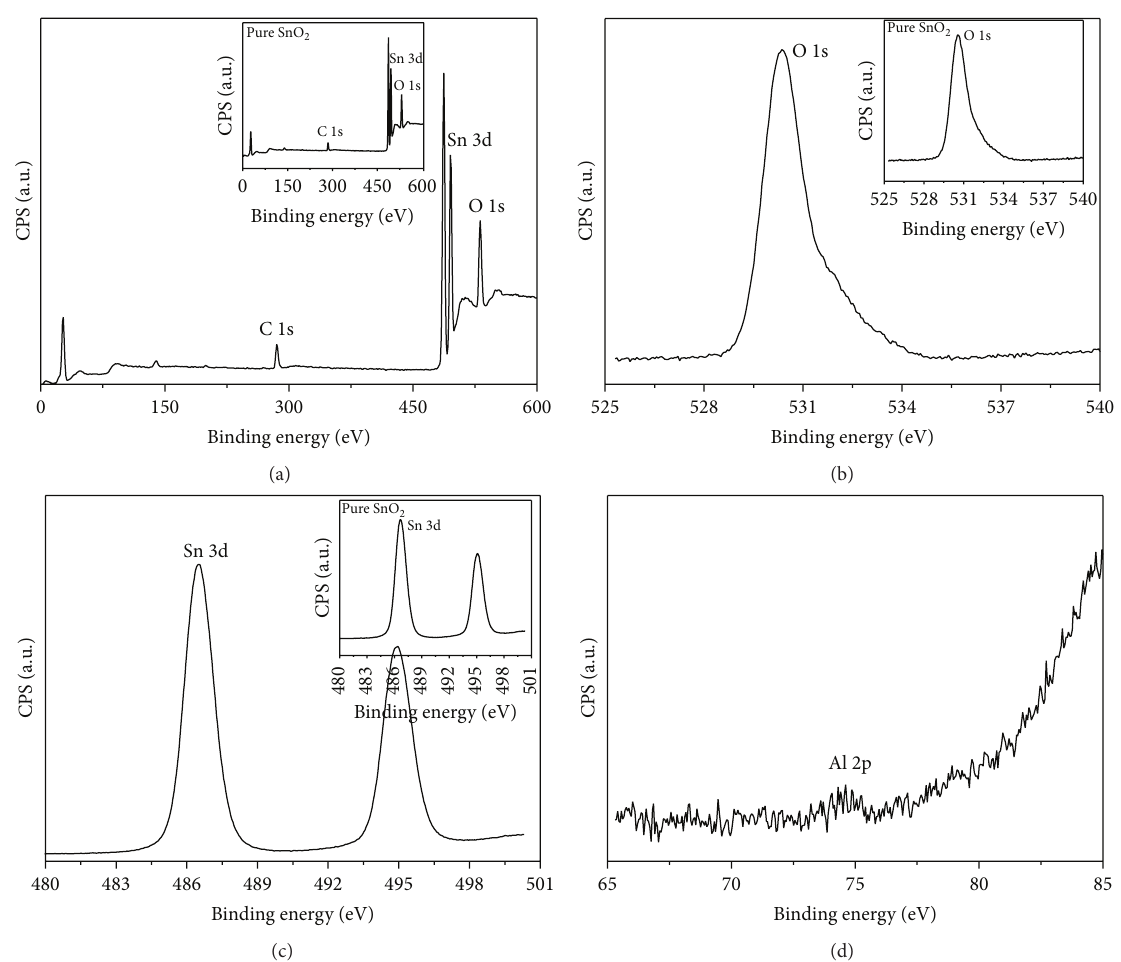
Figure 3: XPS of SnO 2 hollow microspheres doped with 1.5% Al and pure SnO 2 hollow microspheres (given in the insert): (a) full spectra; (b) high resolution of O 1s; (c) high resolution of Sn 3d; (d) high resolution of Al 2p.